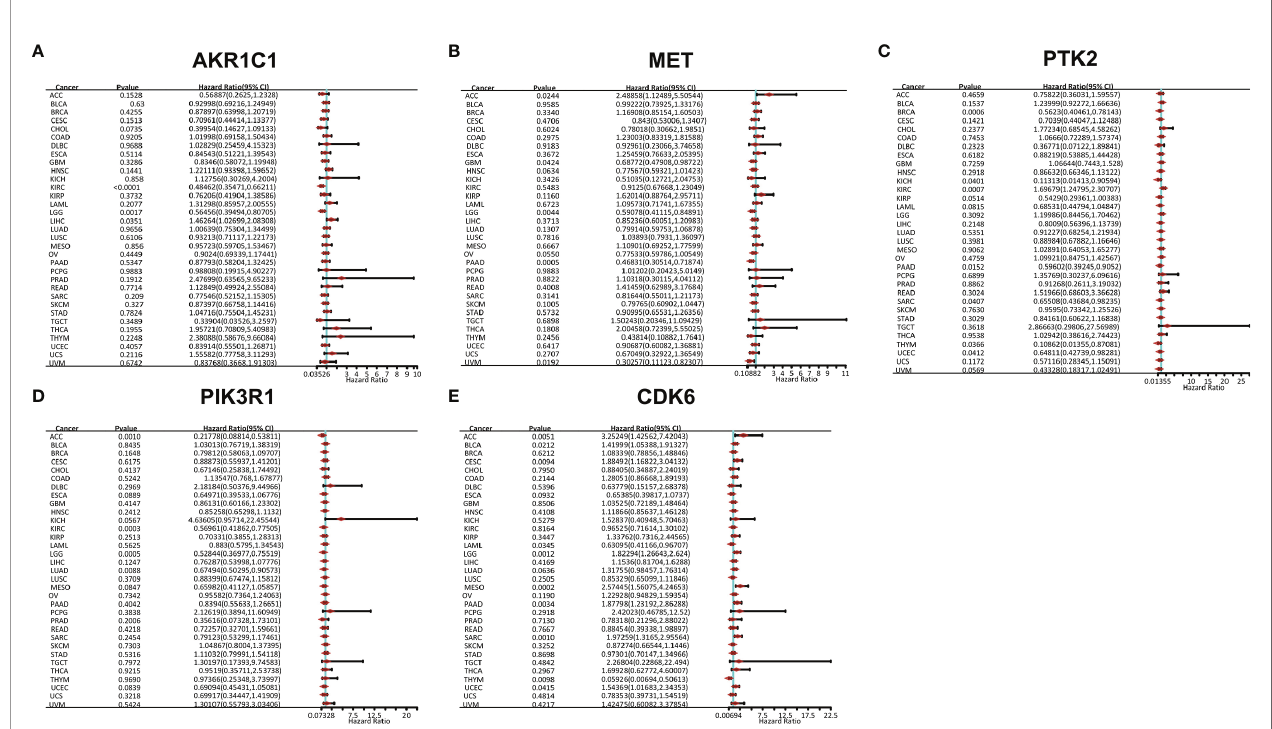
FIGURE 4 | Gene prognostic analysis of potential target proteins of T. hemsleyanum in pan-cancer. (A) AKR1C1. (B) MET. (C) PTK2. (D) PIK3R1. (E)